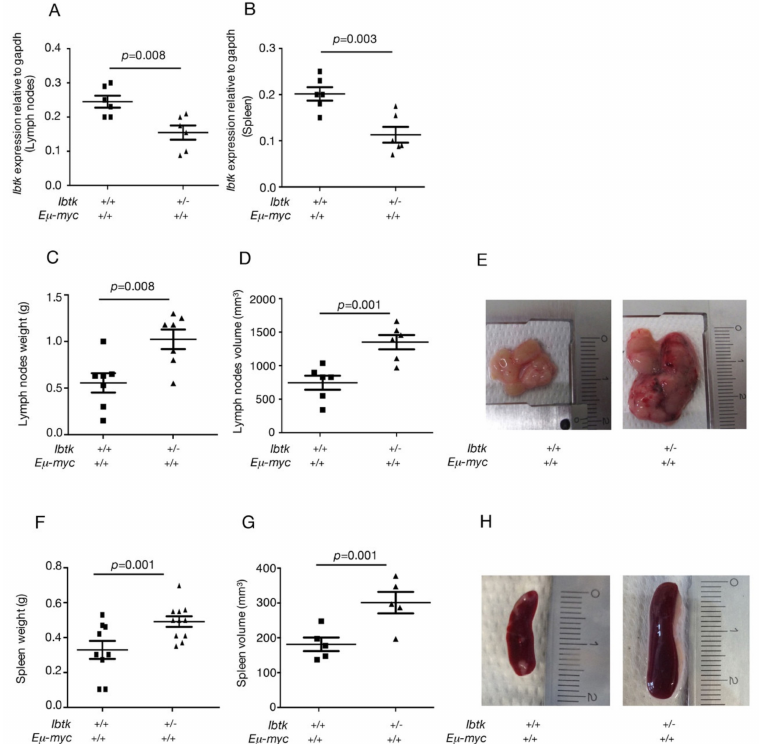
Figure 1. IBTK haploinsu ffi ciency promotes the enlargement of tumor lymph nodes and spleen in E µ -myc mice . A,B. Ibtk mRNA levels were measured by RT-PCR in the tumor lymph nodes and spleen of Ibtk +/+ E µ -myc and Ibtk +/ - E µ -myc mice, and normalized to Gapdh mRNA. C . Weights of lymph nodes of Ibtk +/+ E µ -myc and Ibtk +/ - E µ -myc sick mice. Values are the mean ± SEM ( n = 7 / genotype). D. Volume of lymph nodes of Ibtk +/+ E µ -myc and Ibtk +/ - E µ -myc sick mice. Values are the mean ± SEM ( n = 6 / genotype). E. Representative morphology of tumor lymph nodes. Scale bar is indicated. F. Weights of spleens of sick lymphoma-burdened Ibtk +/+ E µ -myc and Ibtk +/ - E µ -myc mice. Values are the mean ± SEM ( n = 10 / genotype). G. Volume of spleens of sick lymphoma-burdened Ibtk +/+ E µ -myc and Ibtk + - E µ -myc mice. Values are the mean ± SEM ( n = 5 / genotype) H. Representative morphology of tumor spleens. Scale bar is